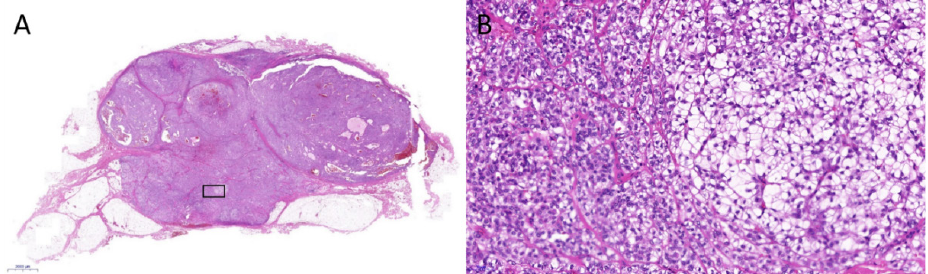
Figure 3. A microscopic view (hematoxylin–eosin stain, ×0.6 in ( A ), ×20 in ( B ), ( B) is magnified view of the black box in ( A ) of the excised specimen shows dense tumor cell proliferation in collagenous septations and focal clear cell changes.